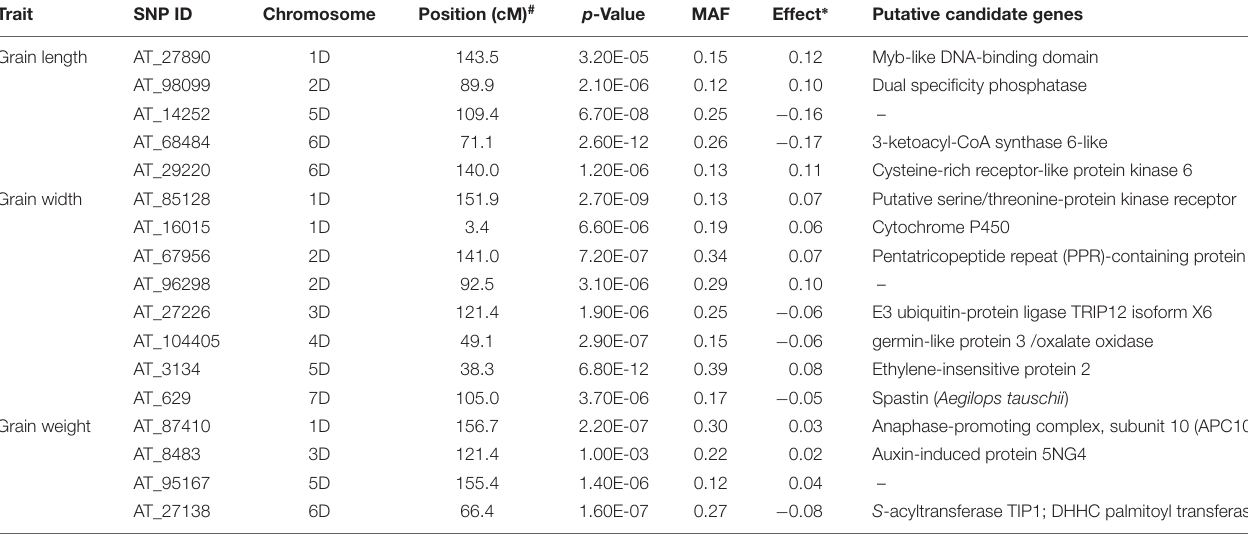
TABLE 2 | Most significant marker loci associated with grain length, width, and weight based on BLUP values of the Ae. tauschii data over 3 years 2011, 2012, and 2013.